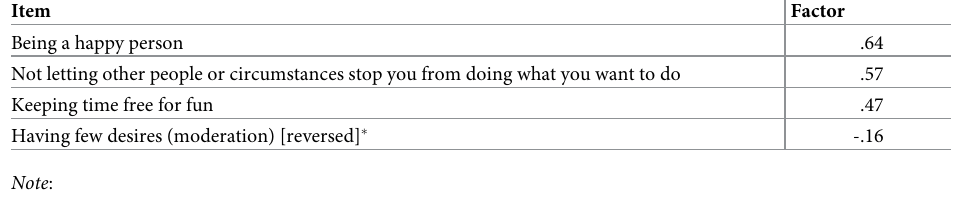
Table 5. Item loadings for a forced single-factor model for indulgence using Principal Axis